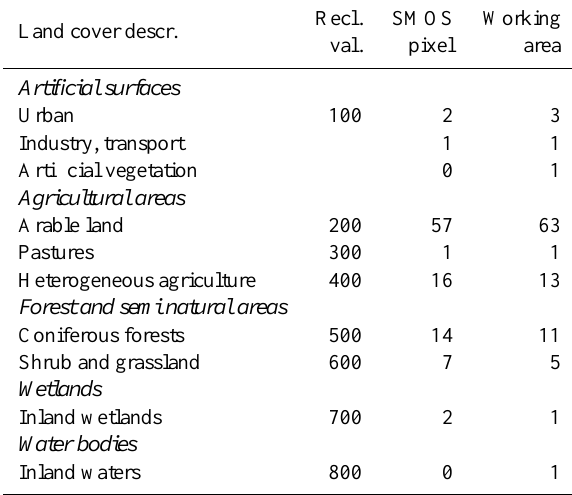
Table 2. Subsoil composition ( > 30cm depth): soil type, class num- bers used in the sum-up to composite classes, clay fractions ( < 2µm) [%] and respective fractions [%] contained in the SMOS pixel and working area around Discrete Global Grid node 2002029.